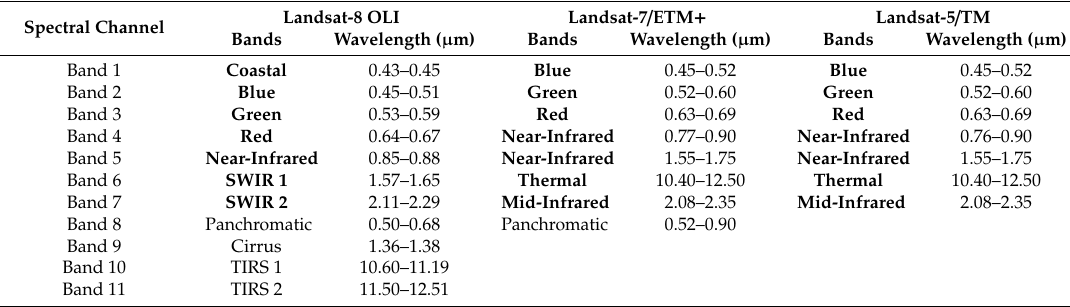
Table 3. Band specifications for Landsat sensors. The bands used in this study are shown in bold. Spectral